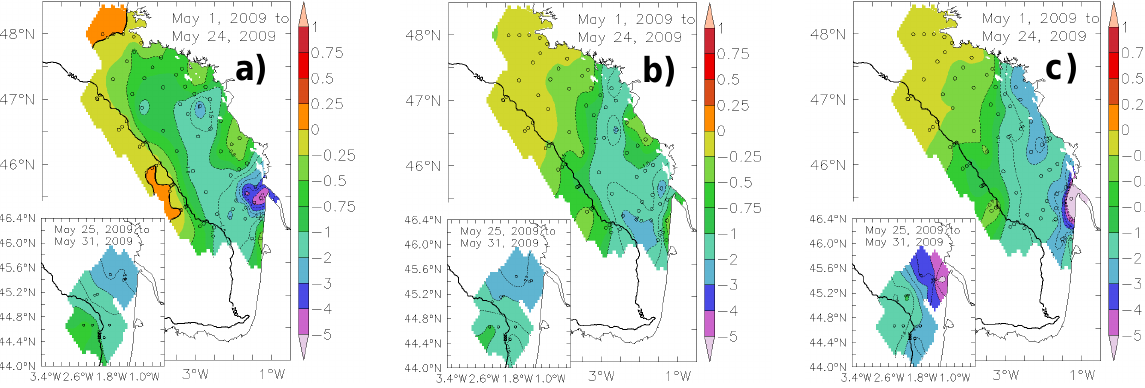
Figure 13 : Same as previous figure but for salinity (psu).